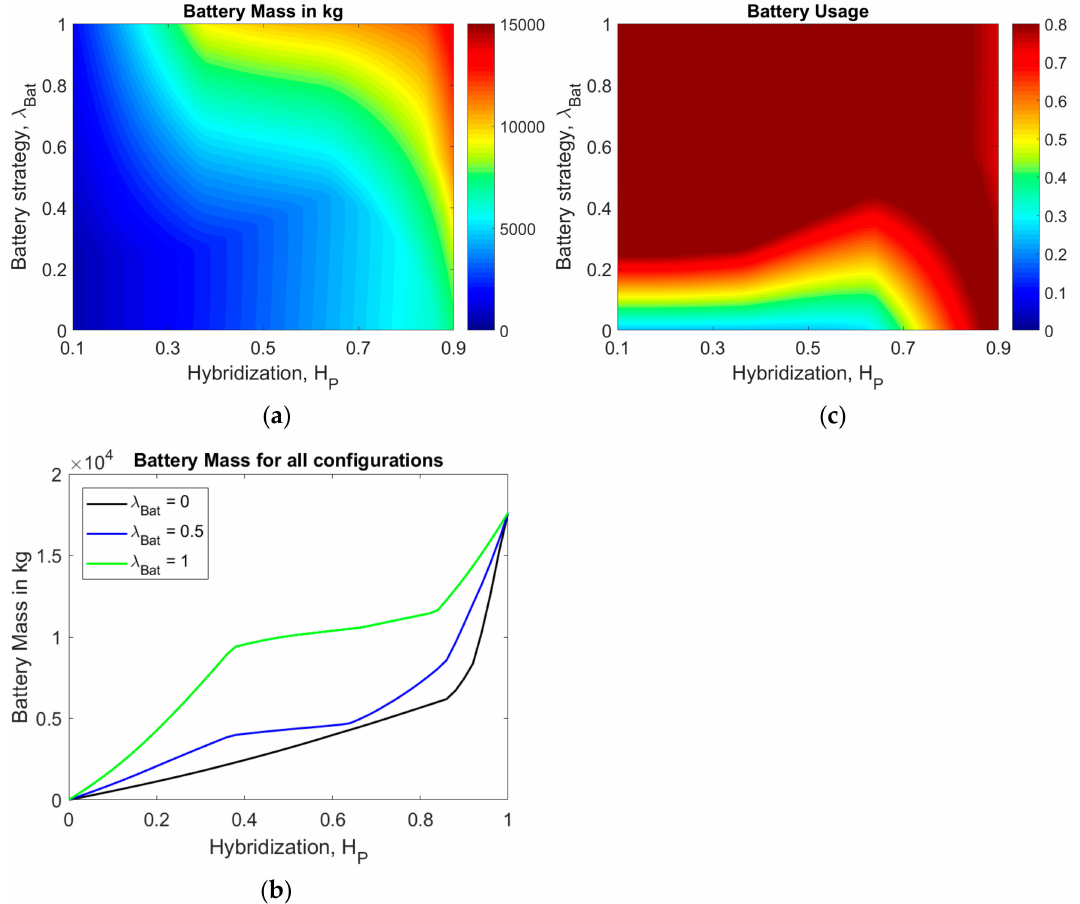
Figure 4. Battery parameters in case of Battery 2 (0.65 kWh/kg, 1 kW/kg): Battery mass in kg for ( a ) Hybrid electric aircrafts ( H P : 0.1–0.9); ( b ) all degrees of hybridization (exemplary λ Bat ); ( c ) Battery